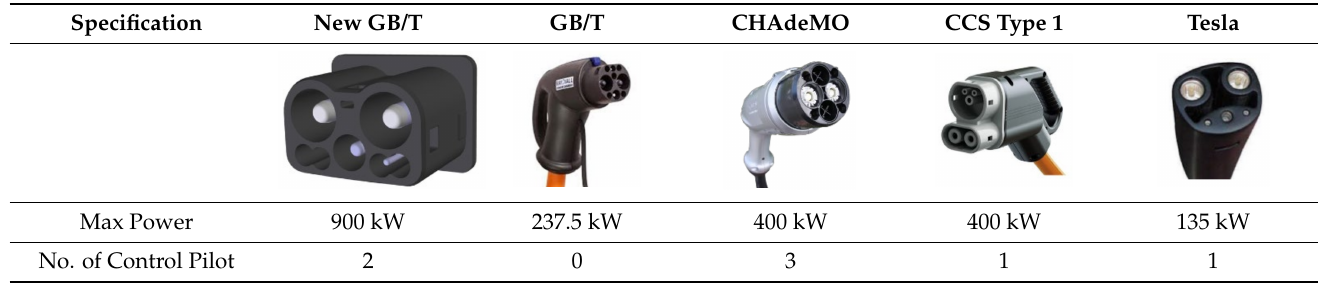
Table 7. Specification comparison of different DC charging connector standards [33].